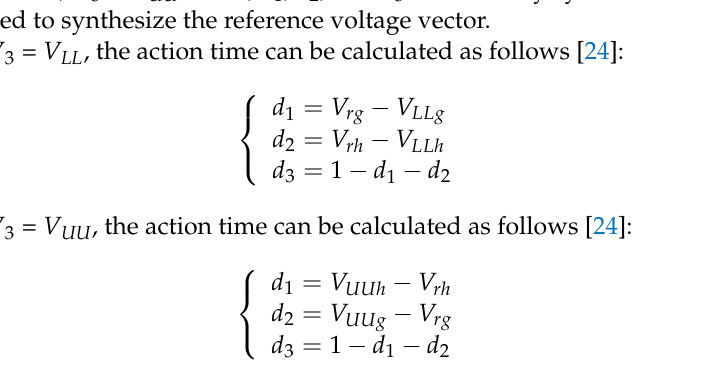
Figure 5. FOC with the SVPWM in the 60° coordinate system.